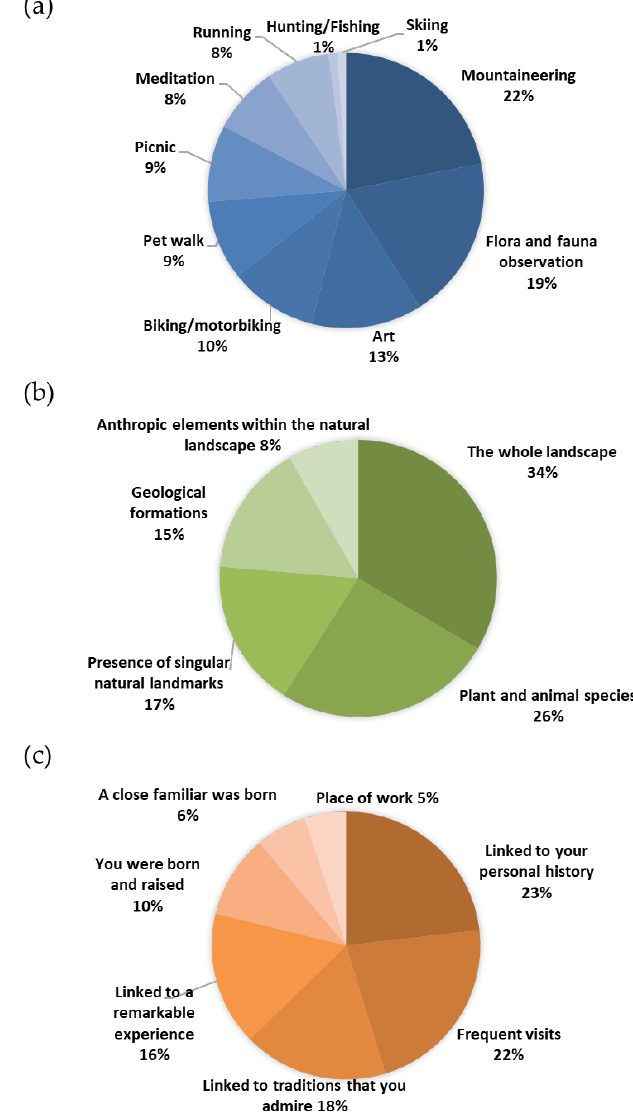
Figure 5. Pie charts depicting questionnaire users’ reasons for choosing the location points for the three CES (( a ) Outdoor recreation, ( b ) Aesthetic enjoyment, ( c ) Sense of place).